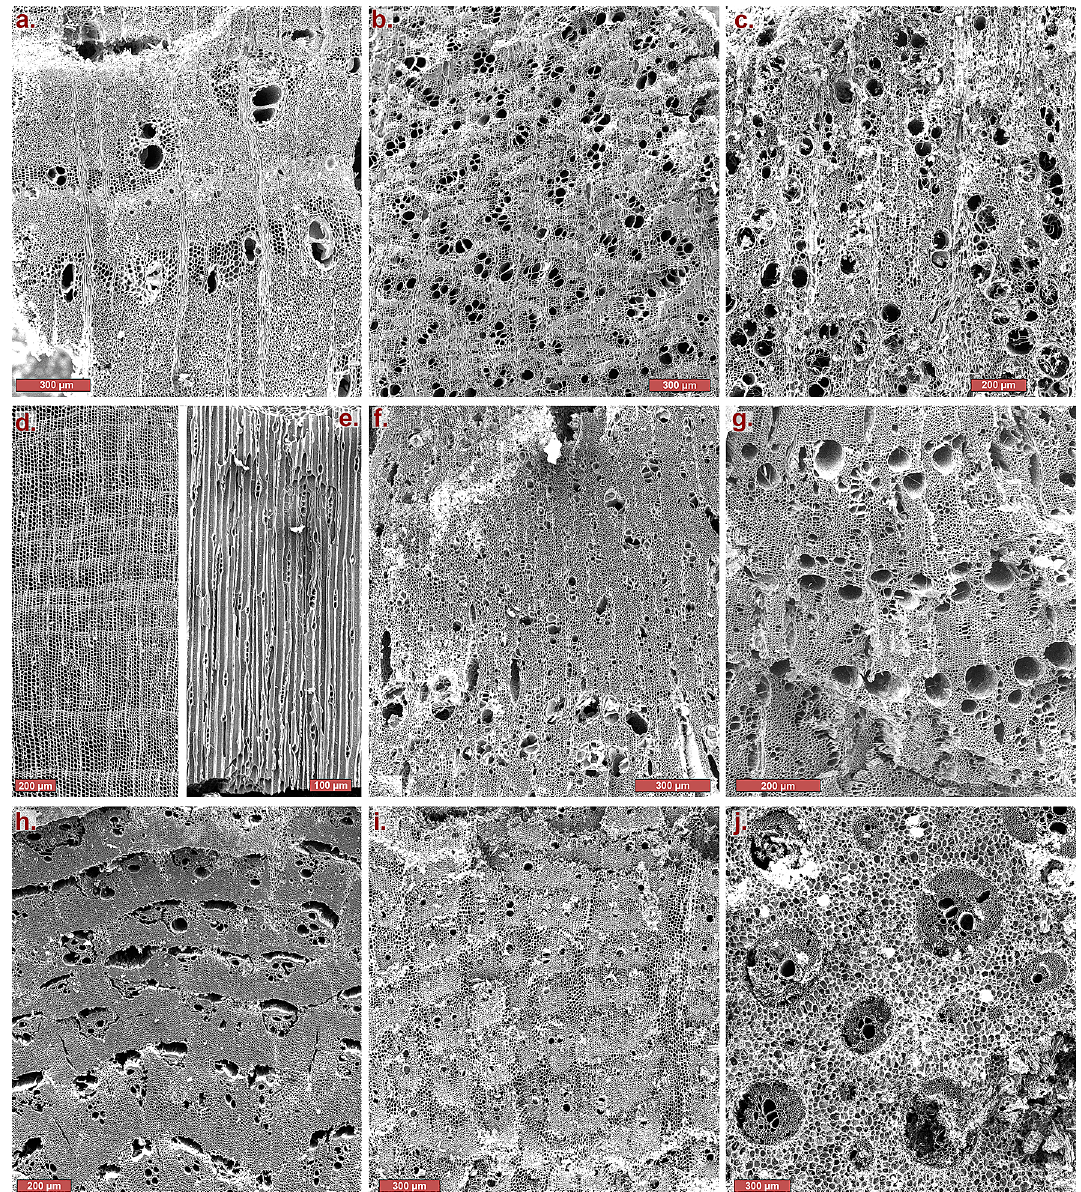
Figure 5. Scanning electron microscope images of select identified taxa with collection locations indicated in parentheses: (a) Acacia sp. (Site 30, Probe 1), transverse; scale 300 μm (b) Retama raetam (Site 30, Probe 5), transverse, scale 300 μm; (c) Retama raetam (root; Site 30, Probe 5), transverse, scale 200 μm; (d) Juniperus phoenicea (Site 30, Probe 2), transverse, scale 200 μm; (e) Juniperus phoenicea (Site 30, Probe 2), tangential, scale 100 μm; (f) Pistacia atlantica -type (Site 34, Probe 3), transverse, scale 300 μm; (g) Pistacia palaestina -type (Site 30, Probe 2), transverse, scale 200 μm; (h) Atriplex halimus -type (Amaranthacaea; Site 30, Probe 2), scale 200 μm; (i) Suaeda fruticosa -type (Amaranthaceae; Site 30, Layer I), trans, scale 300 μm; (j) Phoenix dactylifera (Site 30, Layer I), transverse, scale 300 μm. See Supplementary Figs. S2-S3 for additional microscope